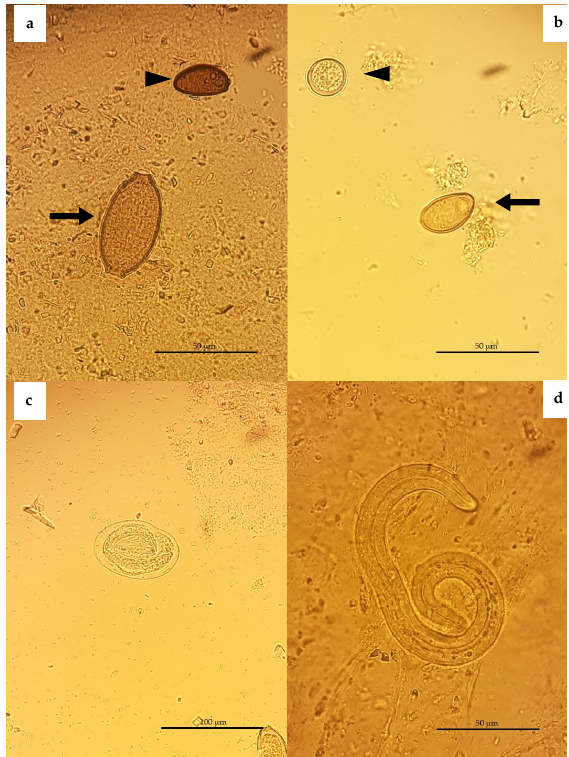
Figure 2. European hedgehog, flotation test with zinc sulphate solution (specific gravity of 1.350). ( a ) Arrow: Capillaria erinacei egg with bipolar plugs, measuring 55.37 µ m × 27.29 µ m on average; Arrowhead: Brachylaemus erinacei egg, measuring 32.18 µ m × 22.91 µ m. ( b ) Arrowhead: Cystoisospora rastegaievae oocyst, mean size 19.12 µ m × 18.23 µ m; Arrow: Brachylaemus erinacei egg. ( c ) Physaloptera clausa egg, mean 42.92 µ m × 28.78 µ m. ( d ) Crenosoma striatum , first-stage larva of 285 µ m × 16 µ m in